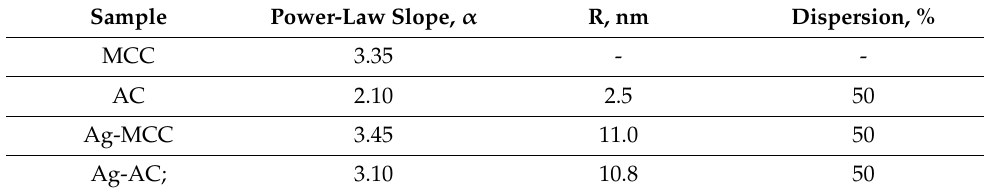
Table 4. Morphological parameters of Ag-cellulose composites from SAXS data.